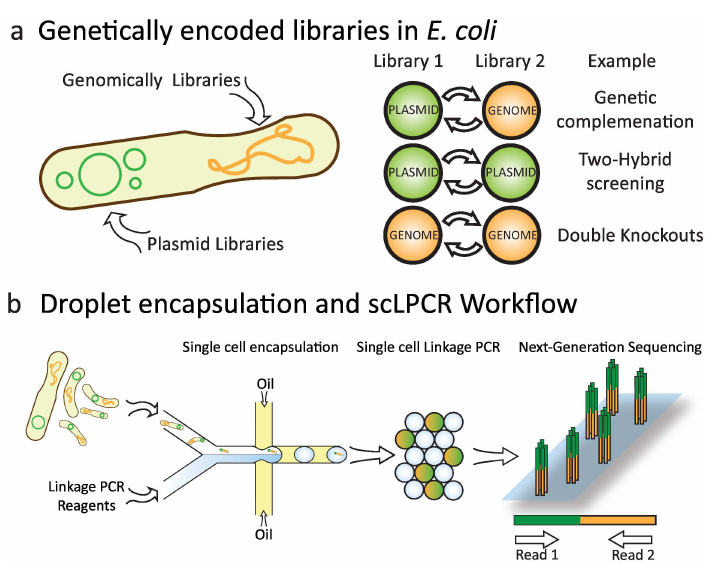
Fig 1. Screening genetic interaction libraries by single-cell sequencing with droplet microfluidics. (a) Genetic libraries can be genomically encodedor introducedthrough episomalDNA like plasmids. Interaction librariesare created by combiningtwo geneticlibraries.Some of the most common types of interaction librariesare noted. (b)Libraries are screen by microfluidic encapsulation and single-cell linkagePCR (scLPCR) inside picoliter droplets. Confiningcells insideof droplets allows PCR to link cellularDNA without crossover contamination of DNA from other cells. The PCR products are sequencedusing paired-end chemistry on an Illumina platform to